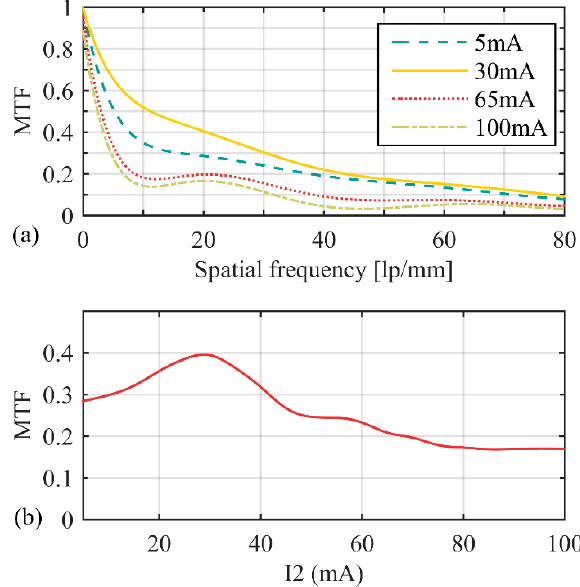
Figure 13. MTF of the zoom system. ( a ) MTFs were measured when I 2 took different values; ( b ) relationship between MTF and I 2 at 20 lp/mm.